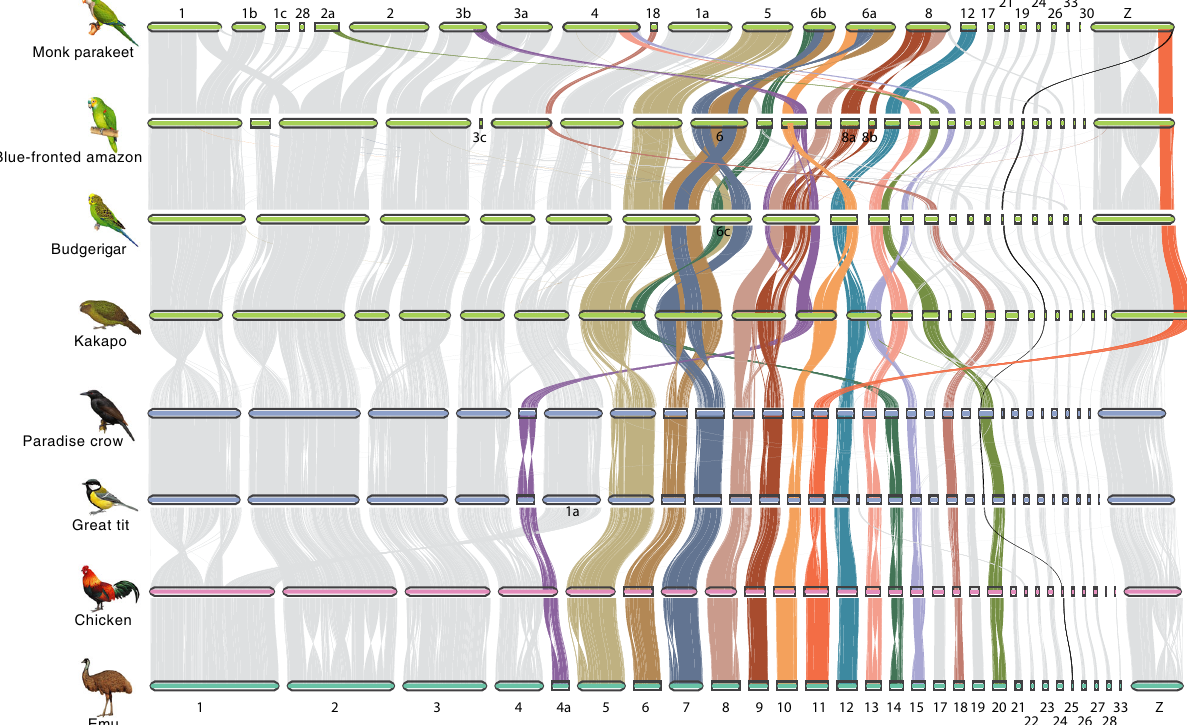
Fig. 2 Frequent chromosomal rearrangements across parrot genomes. Pairwise whole-genome alignments across eight chromosome-level assemblies of bird genomes. Each horizontal bar represents one chromosome, and chromosome IDs of chicken were labeled at the bottom; for parrot genomes some chromosomes were renamed following chromosome fi ssions. Chromosomes that experienced recurrent chromosomal rearrangements are highlighted in colors. Chromosome 11 and 25 are highlighted in color which were fused to the sex chromosome in monk parakeet. Illustrations reproduced by permission of Lynx